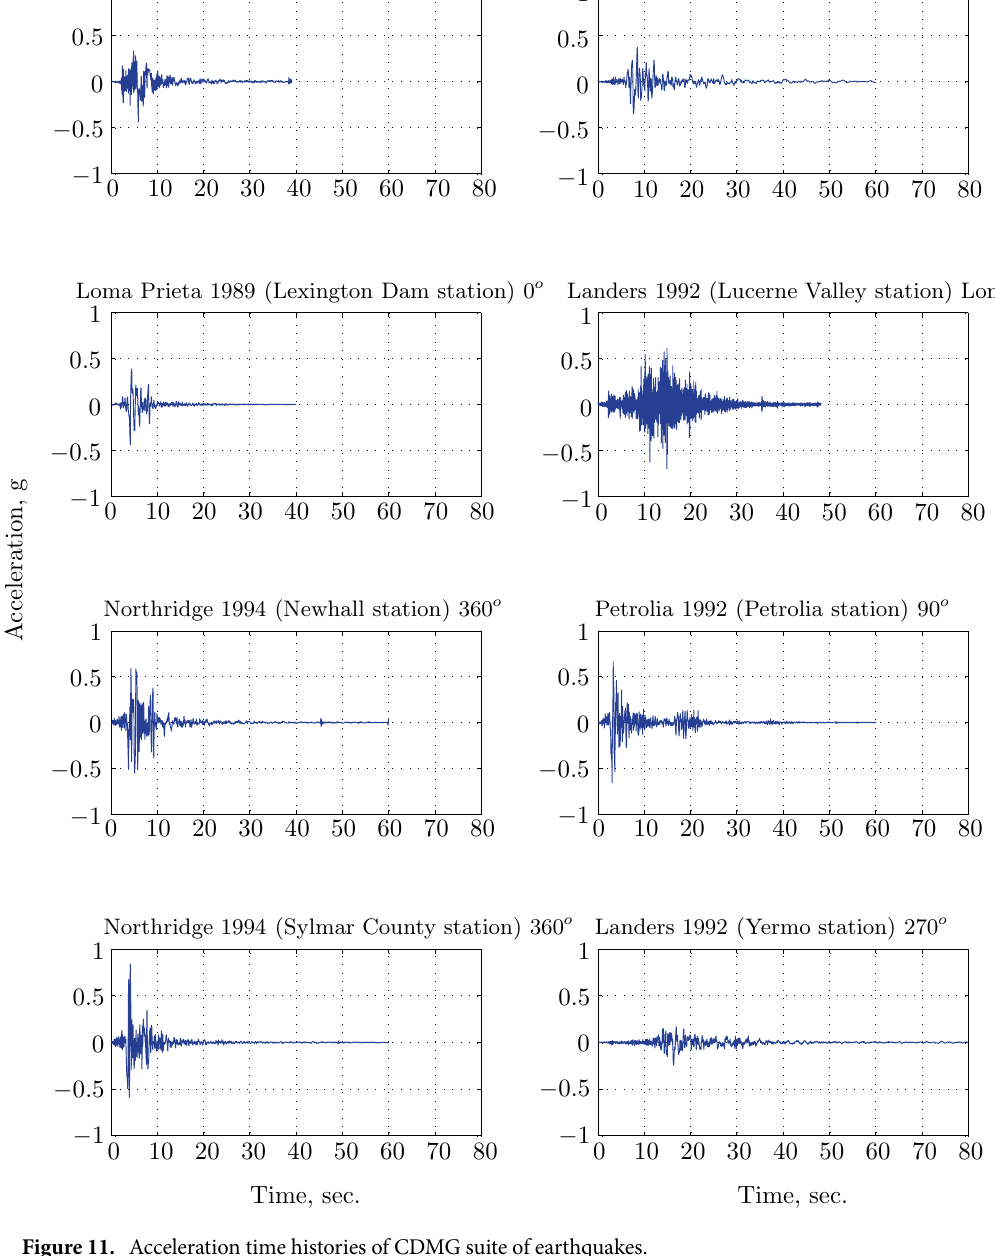
Figure 11. Acceleration time histories of CDMG suite of